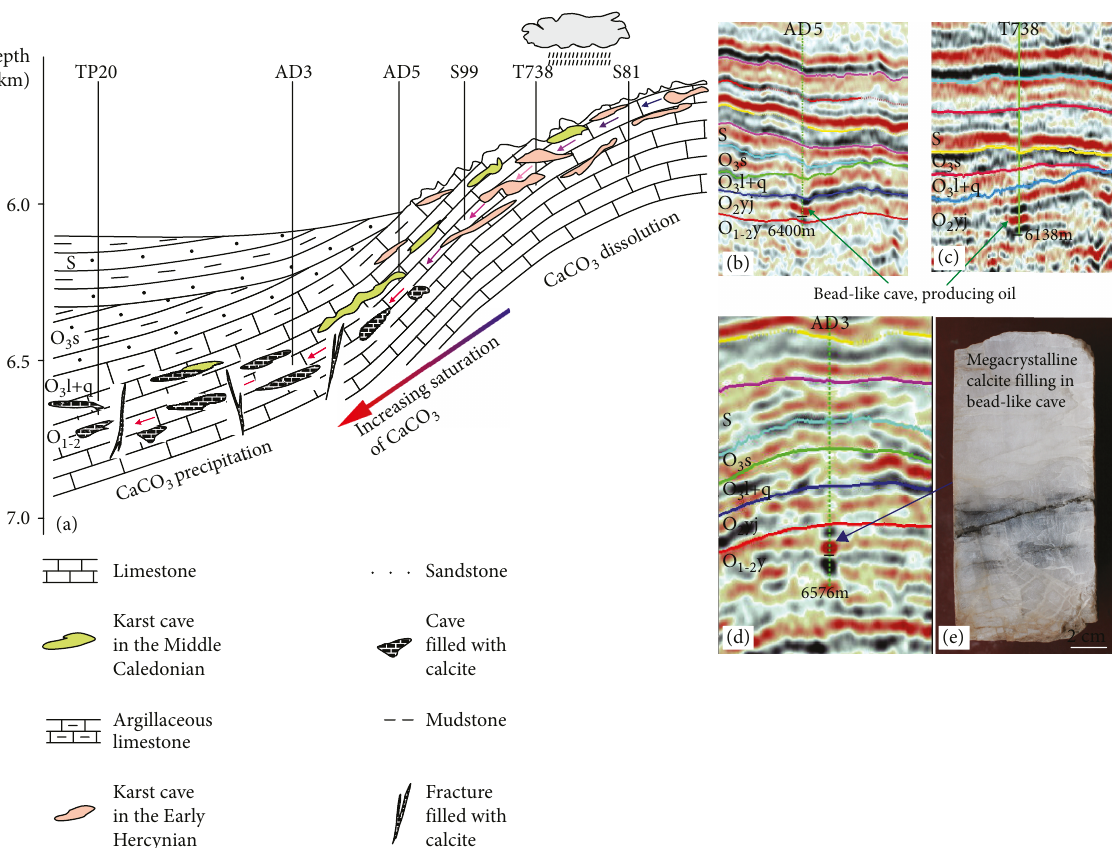
Figure 8: Developing model of dissolution and cementation in the Ordovician carbonate reservoir in the tectonic uplift-meteoric water environment in the Tahe oil fi eld, Tarim Basin. (a) Dissolution-cementation model. (b) Seismic pro fi le crossing AD5 well located in the uplift area shows karst cave with bead-like re fl ection, and the karst cave produced oil. (c) Seismic pro fi le crossing T738 well located in the slope area shows karst cave with bead-like re fl ection, and the karst cave produced oil. (d) Seismic pro fi le crossing AD3 well located in the depression area shows karst cave with bead re fl ection, but the karst cave was fi lled with calcite and did not produce oil. (e) 2.7m thick megacrystalline calcite in the karst cave in AD3